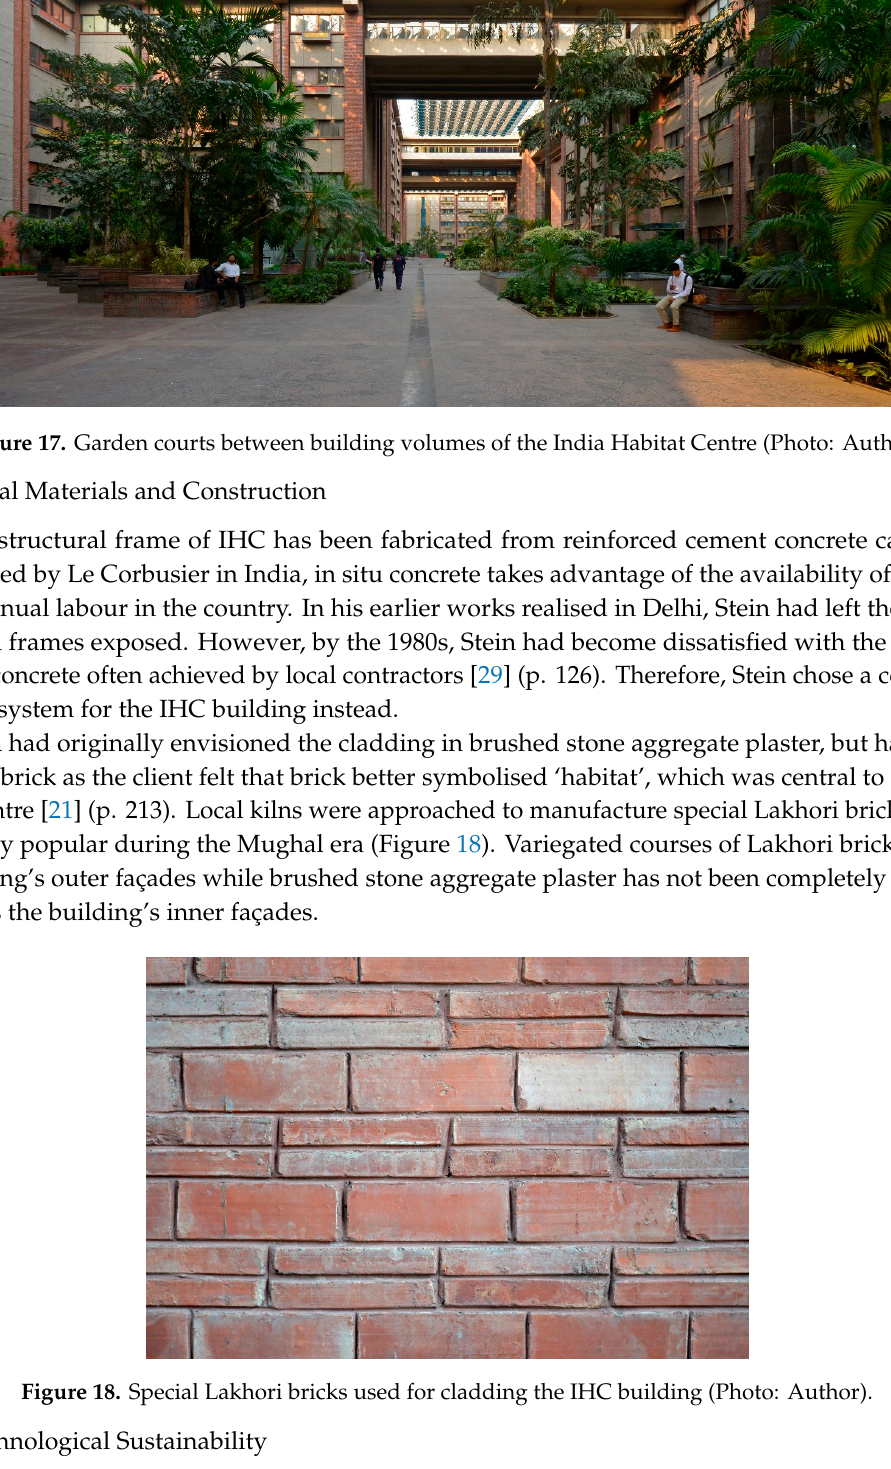
Figure 18. Special Lakhori bricks used for cladding the IHC building (Photo: Author).